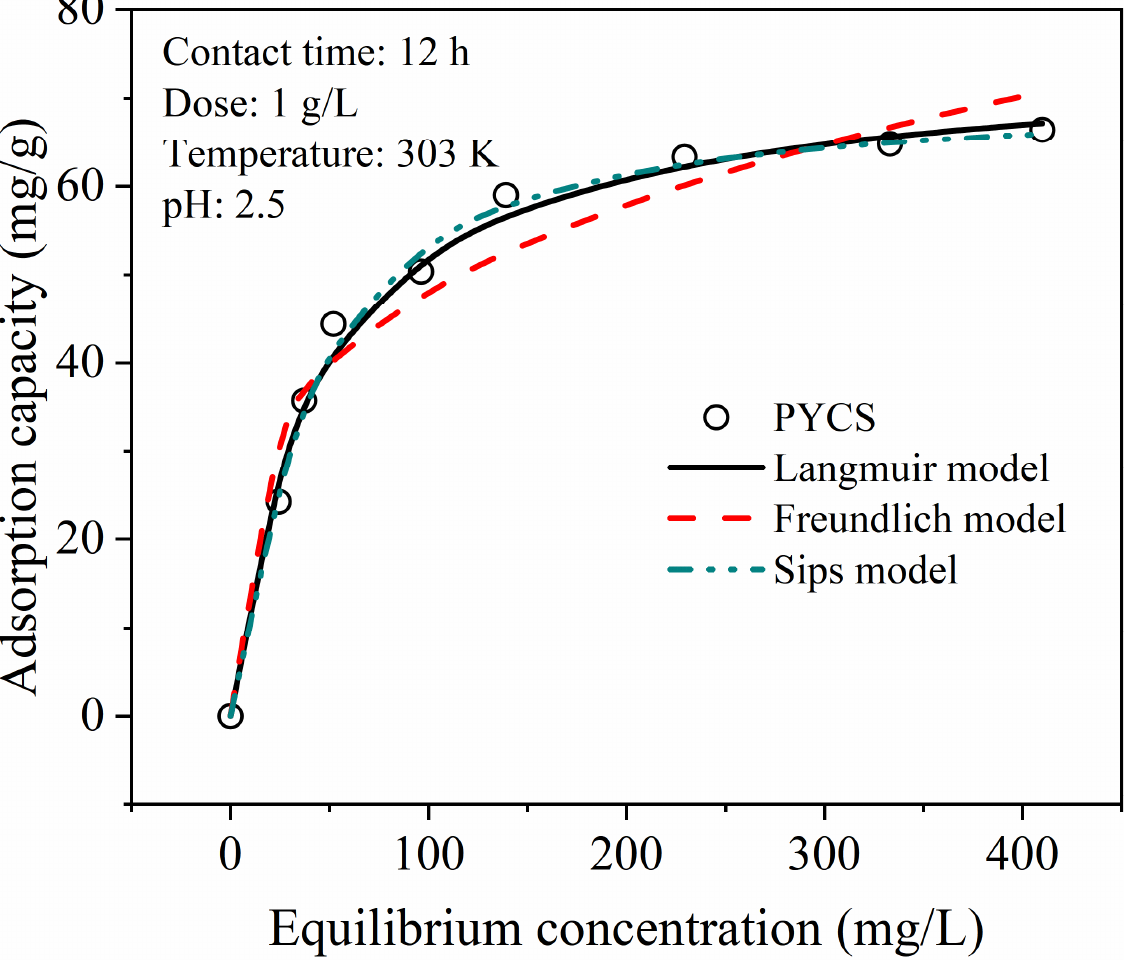
Figure 5. Adsorption isotherms of Fe (III) on PYCS.